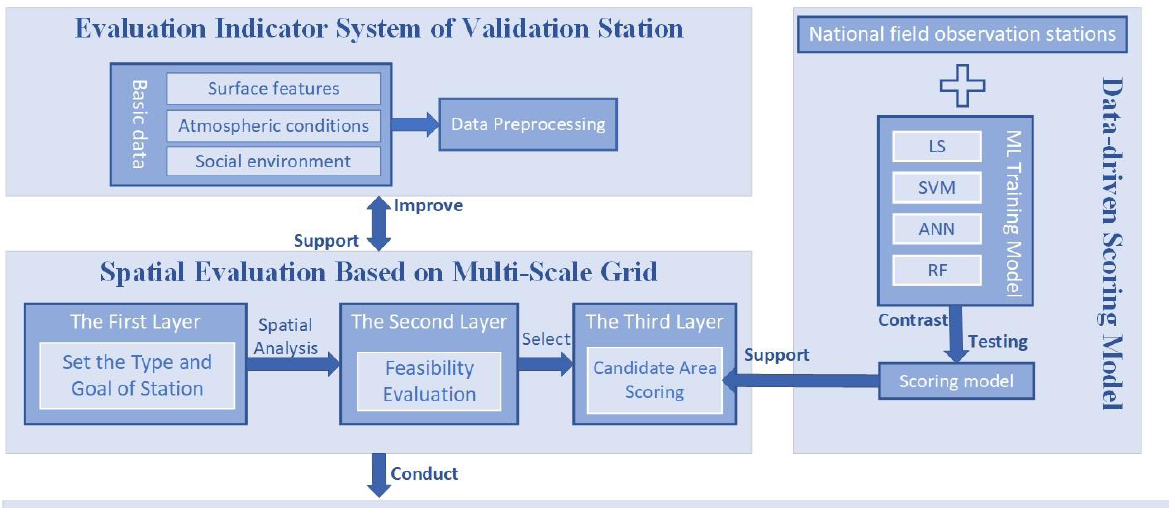
Figure 2. Flow chart of DSS-LPV.